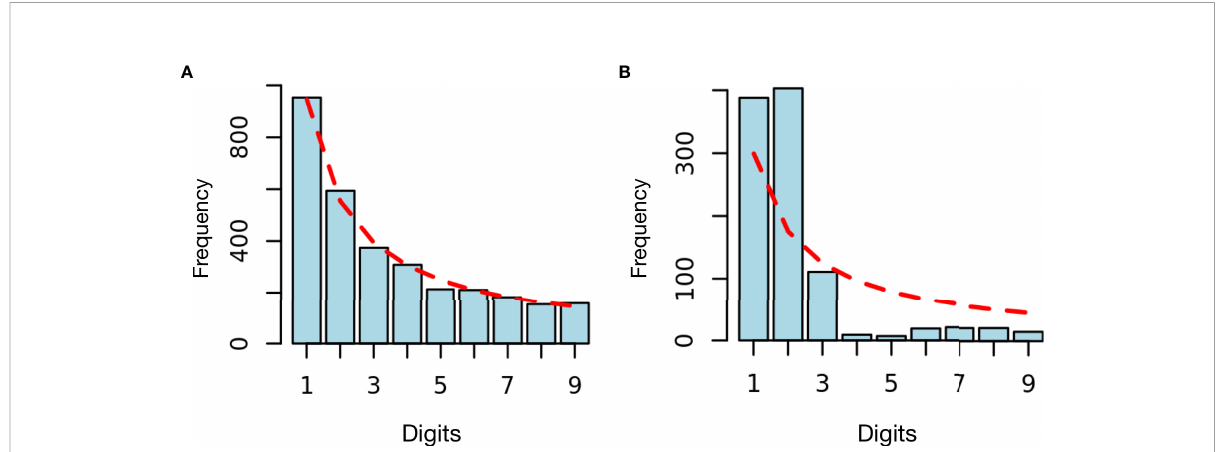
FIGURE 2 Two hypothetical fi rst-digit distributions. The fi rst (A) conforms to the Benford distributions and the second (B) does not. The blue bars are the observed hypothetical data, and the red dashed lines are the expected Benford distribution.